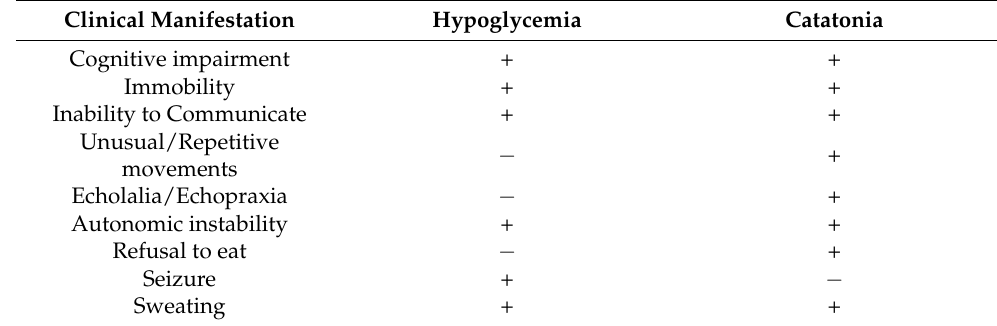
Table 1. Clinical manifestations of hypoglycemia and